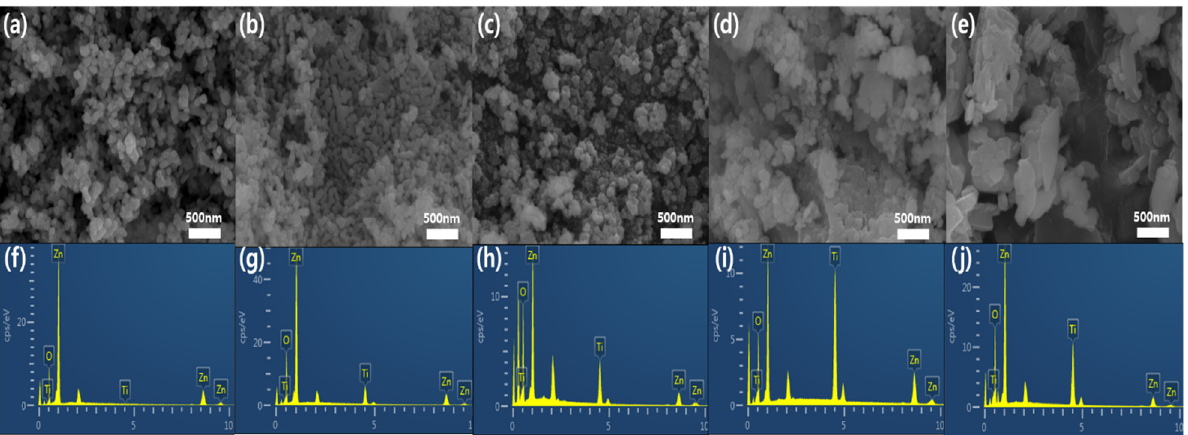
Figure 1. SEM images of plasma-synthesized composites of zinc and titanium oxide; the SEM images of ( a – e ) are taken from the samples of Zn@Ti-A, Zn@Ti-B, Zn@Ti-C, Zn@Ti-D, and Zn@Ti-E, respectively. The graphs of ( f – j ) are EDS of ( a – e ), respectively.